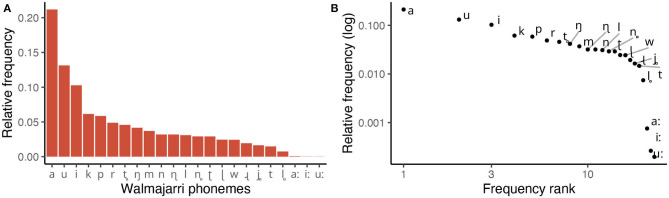
Frequency of phonemes in Walmajarri lexicon (Hudson and Richards, 1993). (A) Displays relative frequencies of each segment type. (B) Shows the same frequencies on log-transformed x and y axes—the traditional visual device used to identify power laws.